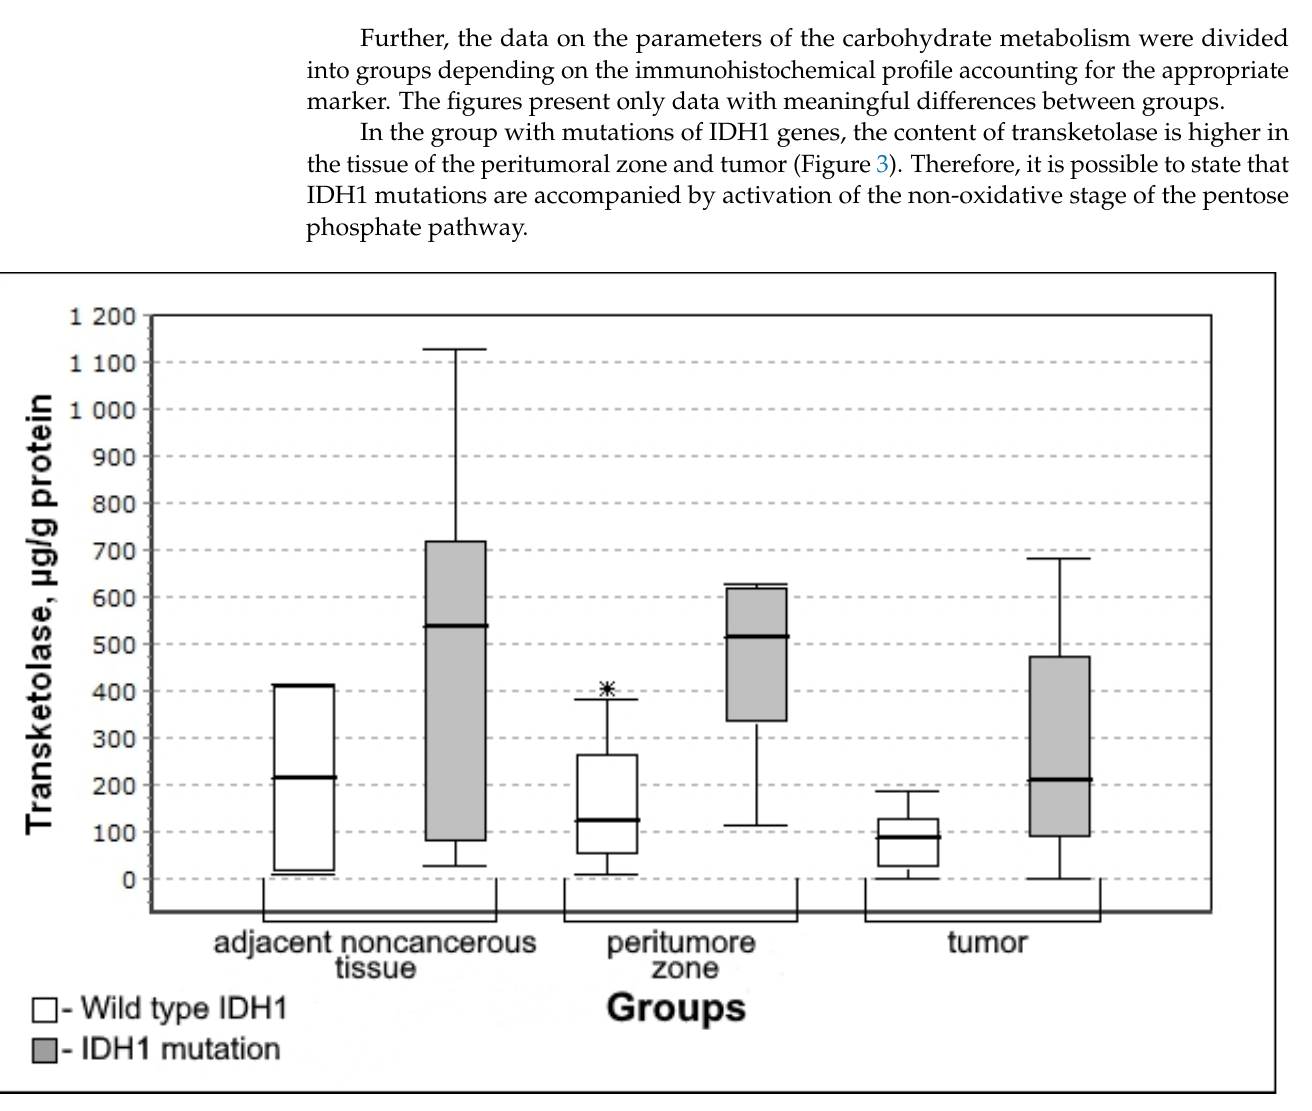
Figure 3. Medians and interquartile ranges (IQR) of the content of transketolase in the glioma tissue depending on the mutation of genes in iso-enzyme of the isocitrate dehydrogenase IDH1 (IDH1 mutation n = 12; wild type IDH1 n = 8). Statistics are reported * p < 0.05.